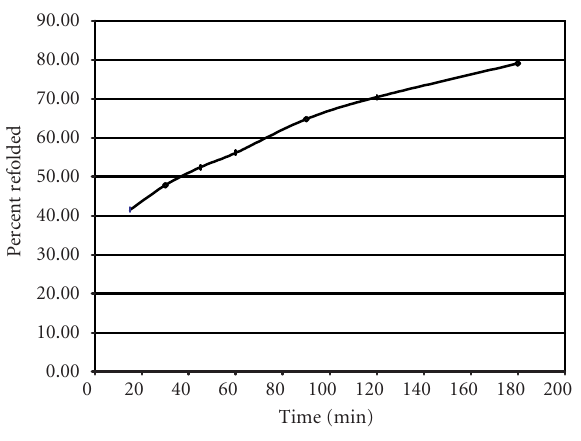
Figure 2: Reversibility of cutinase at pH 4 . 0 . Cutinase has been heated and after cooling to 5 degrees different wait times have been introduced to account for the time necessary to refold the enzyme, before reheating the protein solution. The % refolding values have been obtained as relative values based on the values obtained from the first scan.